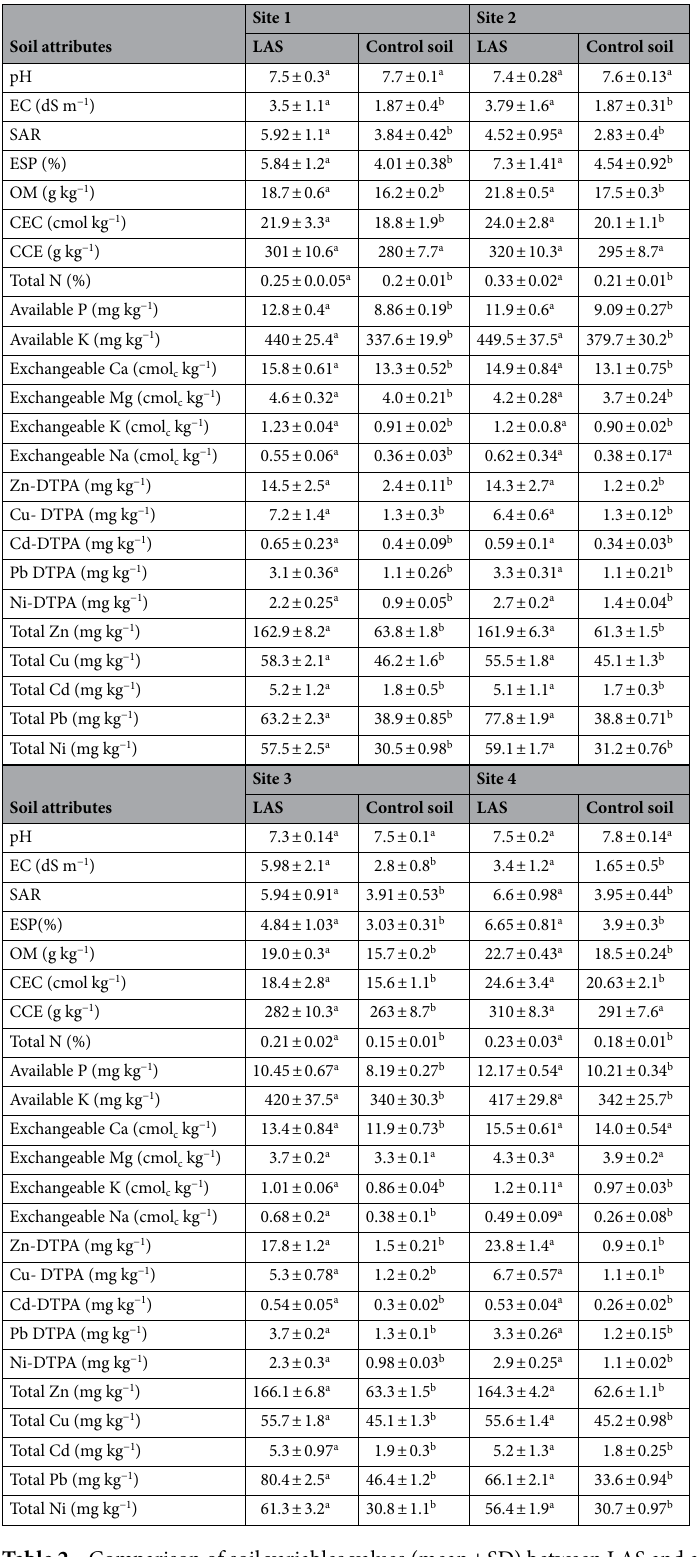
Table 2. Comparison of soil variables values (mean ± SD) between LAS and adjacent control soil (n = 60). SD: standard deviation; LAS: leachate-affected soil; OM: organic matter; CCE: calcium carbonate equivalent; CEC: cation exchange capacity; EC: electrical conductivity; SAR: sodium adsorption ratio; ESP: exchangeable sodium percentage. Different letters in each row show significant differences at P < 0.05 based on the paired